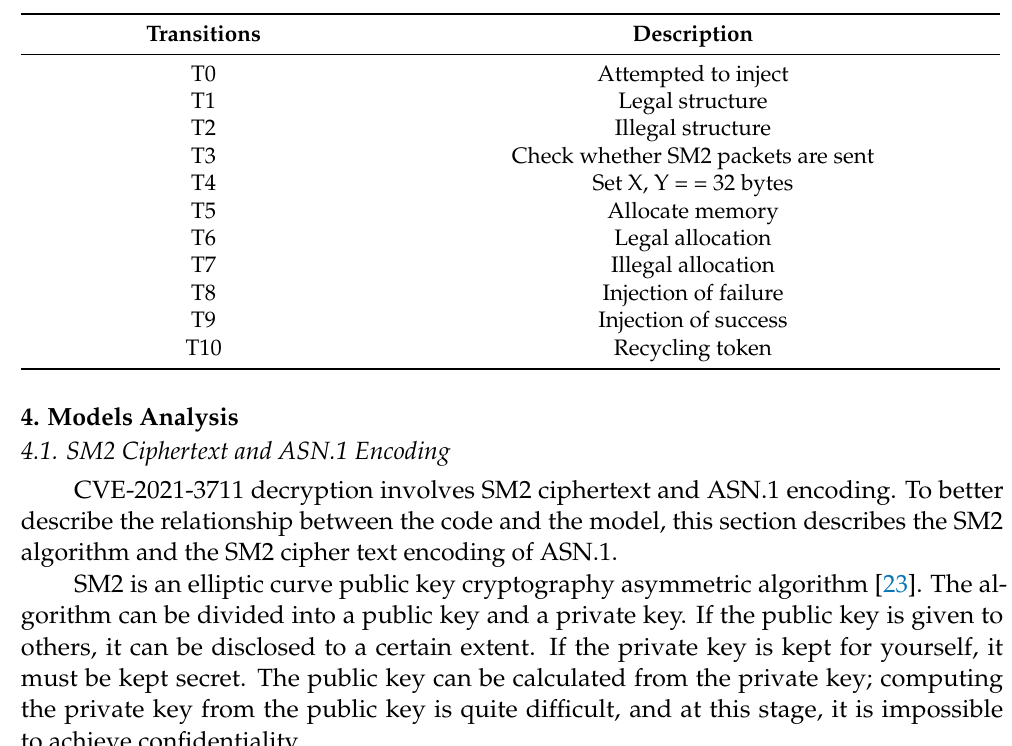
Table 2. The meaning of